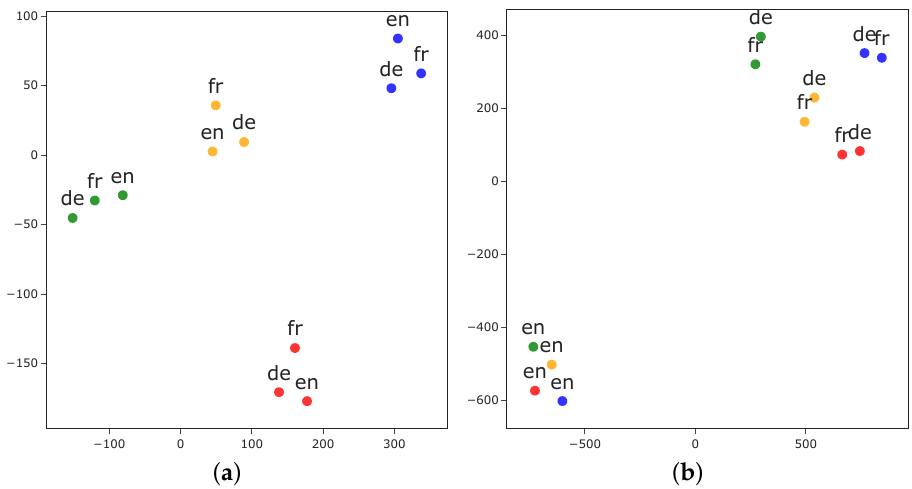
Figure 5. Interlingual embeddings for four groups of parallel En, De, and Fr sentences from the M2 model trained in the M2M and JM2M environments, respectively. ( a ) M2M ( b ) JM2M. t-SNE is used to project the 256-dimensional mean-pooled interlingual sentence embeddings down to R 2 . The colors and content of the sentences are shown in Table 1.